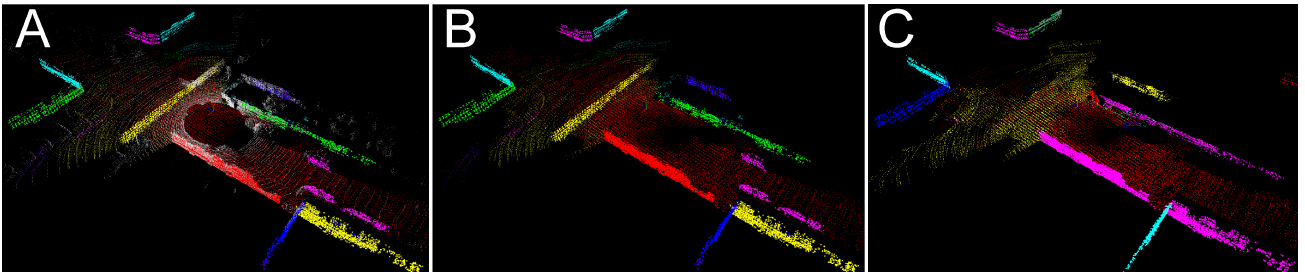
Figure 11. Influence of the motion segmentation filter on the PlaneLOAM map consisting of high-level features indicated by points in random colors: current LiDAR scan shown as white points overlaid on the map with a moving vehicle (yellow) being visible ( A ), a map built without filtration of the non-stationary objects—invalid features created from points measured on cars are visible as yellow and purple segments on the road ( B ), a map built by PlaneLOAM from the filtered scans is free from these features ( C